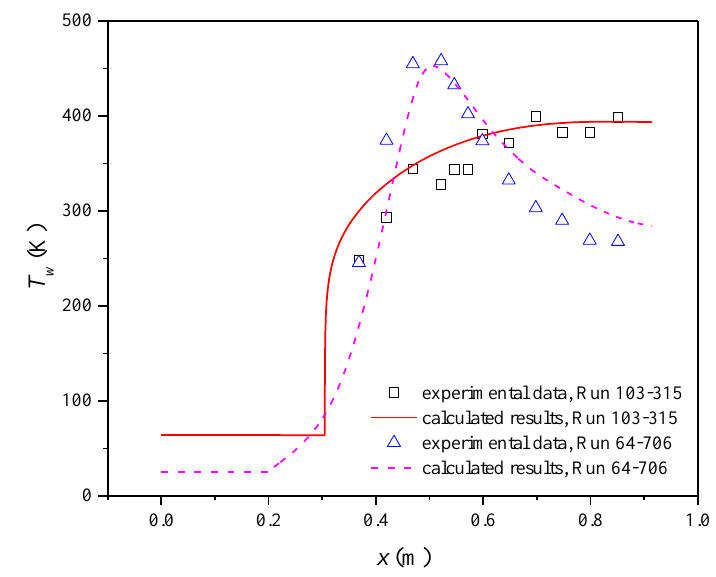
Figure 8. Comparison of the calculated wall temperature with experimental data.